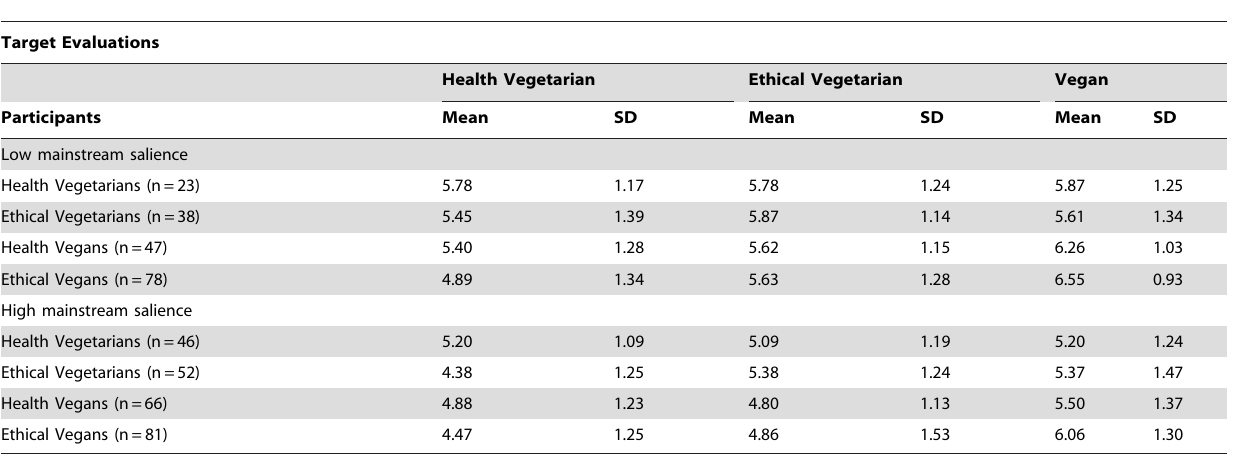
Table 1. Vegetarians’ and Vegans’ Ingroup and Outgroup Evaluations under Low and High Mainstream Salience.